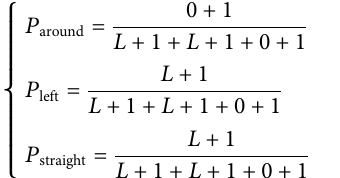
FIGURE 6 | Vehicle driving into unplanned